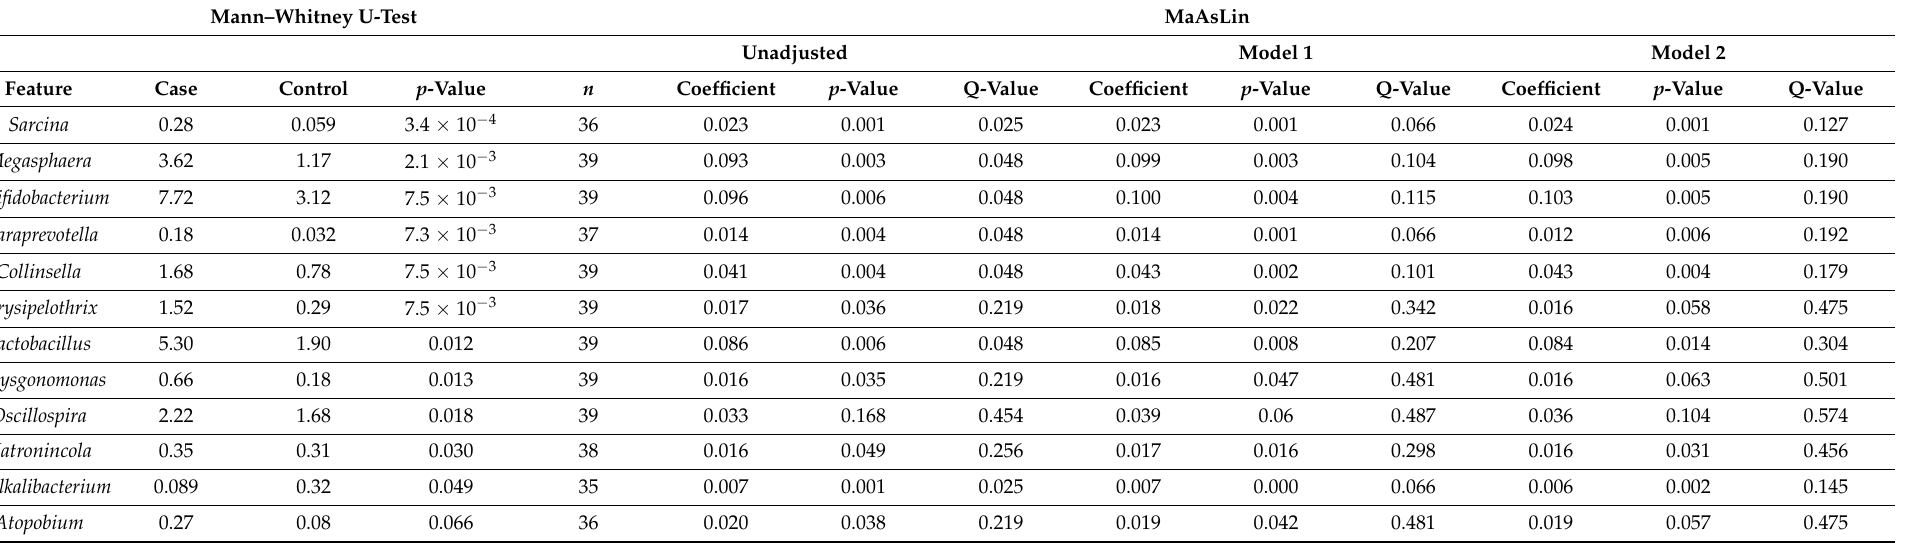
Table 2. Statistically significant differences between PCOS cases and controls at the genus level.